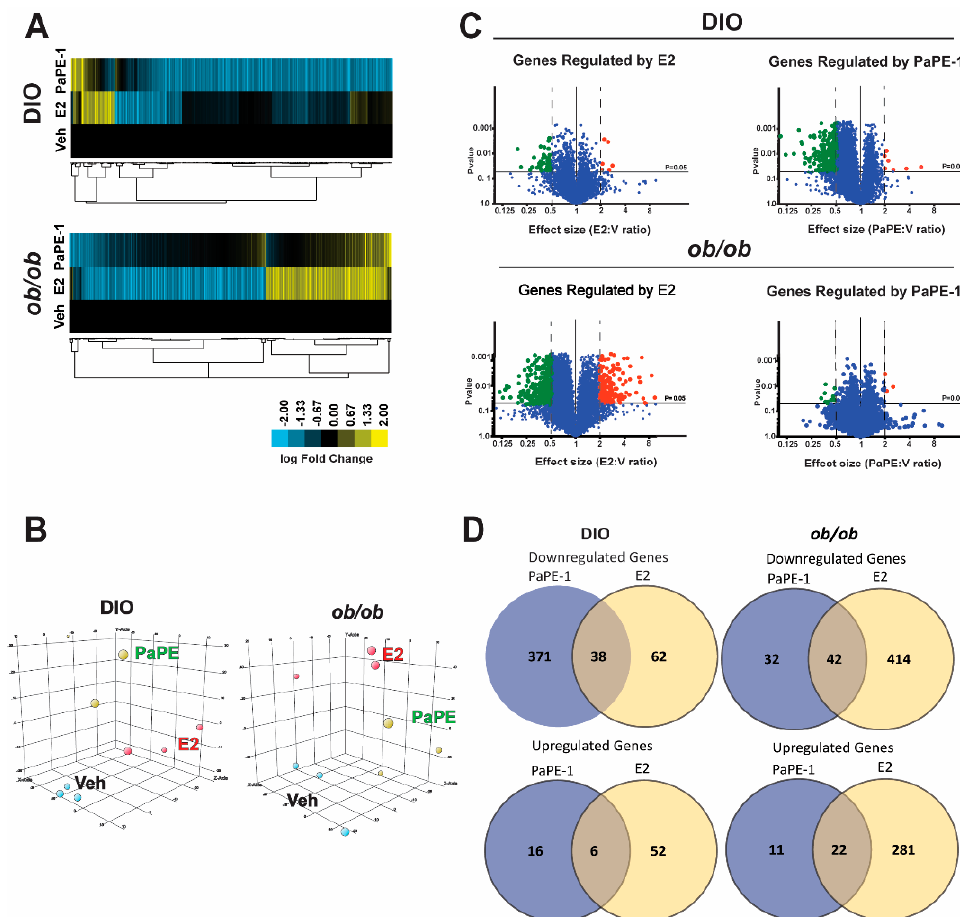
Figure 2. Transcriptomic changes in the liver from DIO and ob/ob mice. ( A ) RNA was isolated from the liver and RNA − seq was performed. Regulated genes are those with p < 0.05 and expression fold change > 2 ( n = 3 biological replicates). ( B ) PaPE − 1and E2 treatments show distinct gene regulation patterns. ( C ) Volcano plots of gene expression data show several genes significantly affected by PaPE − 1 treatment differ from those affected by E2 treatment. Statistical significance was determined at p = 0.05 and greater than a 2 − fold change. Significantly downregulated genes are highlighted in green and upregulated genes are highlighted in red. ( D ) The Venn diagrams display the relationships of downregulated and upregulated genes between DIO and ob/ob mice, respectively. The genes shown in the diagrams are all genes significantly regulated by E2 and PaPE − 1.